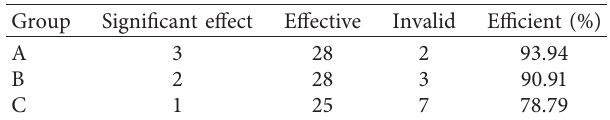
Table 4: Overall efficacy evaluation of patients in each group during the follow-up period (7th